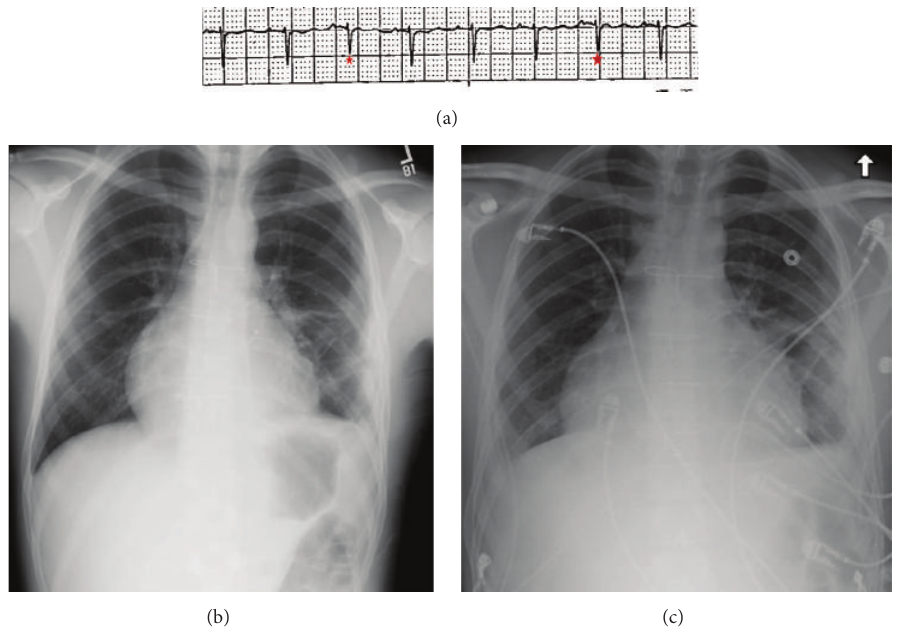
Figure 1: (a) Electrocardiographic strip showing sinus tachycardia and evidence of electrical alternans. (Note the smaller voltage of the QRS complexes annotated compared to others.) Posterolateral chest X-ray at last discharge (b) and at presentation (c) showing the increased size of cardiac silhouette.